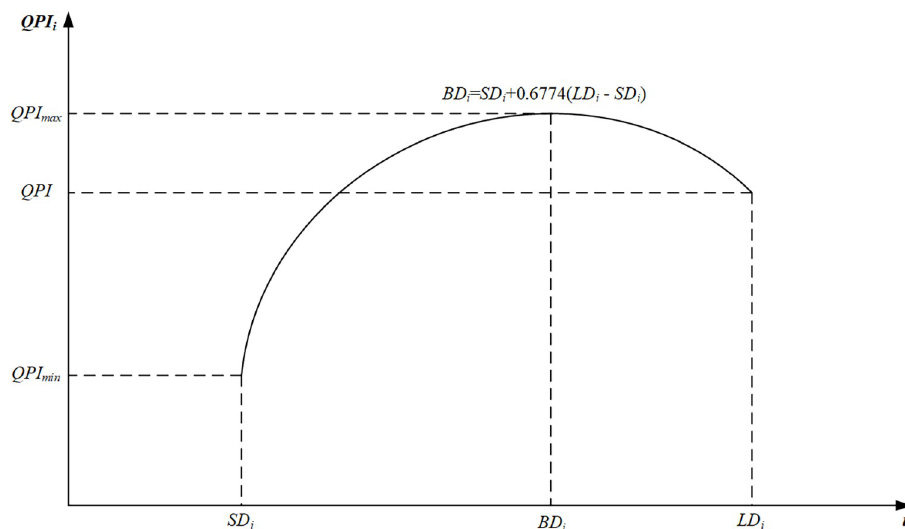
Fig 8. The curve of the relationship of time-